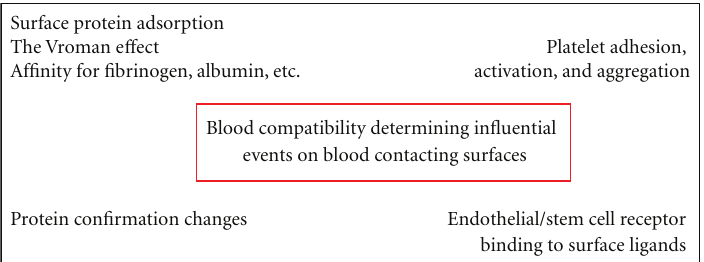
Figure 3: Main mechanisms influencing blood